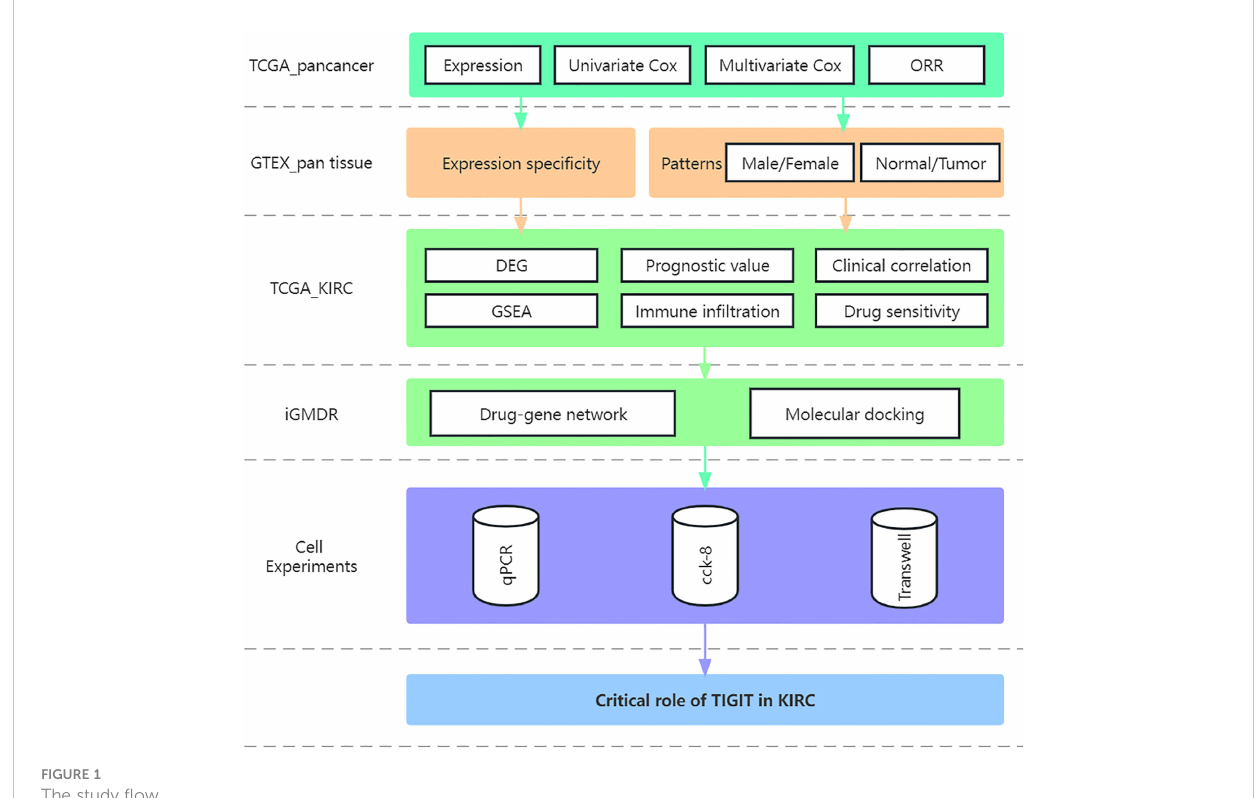
FIGURE 1 The study fl